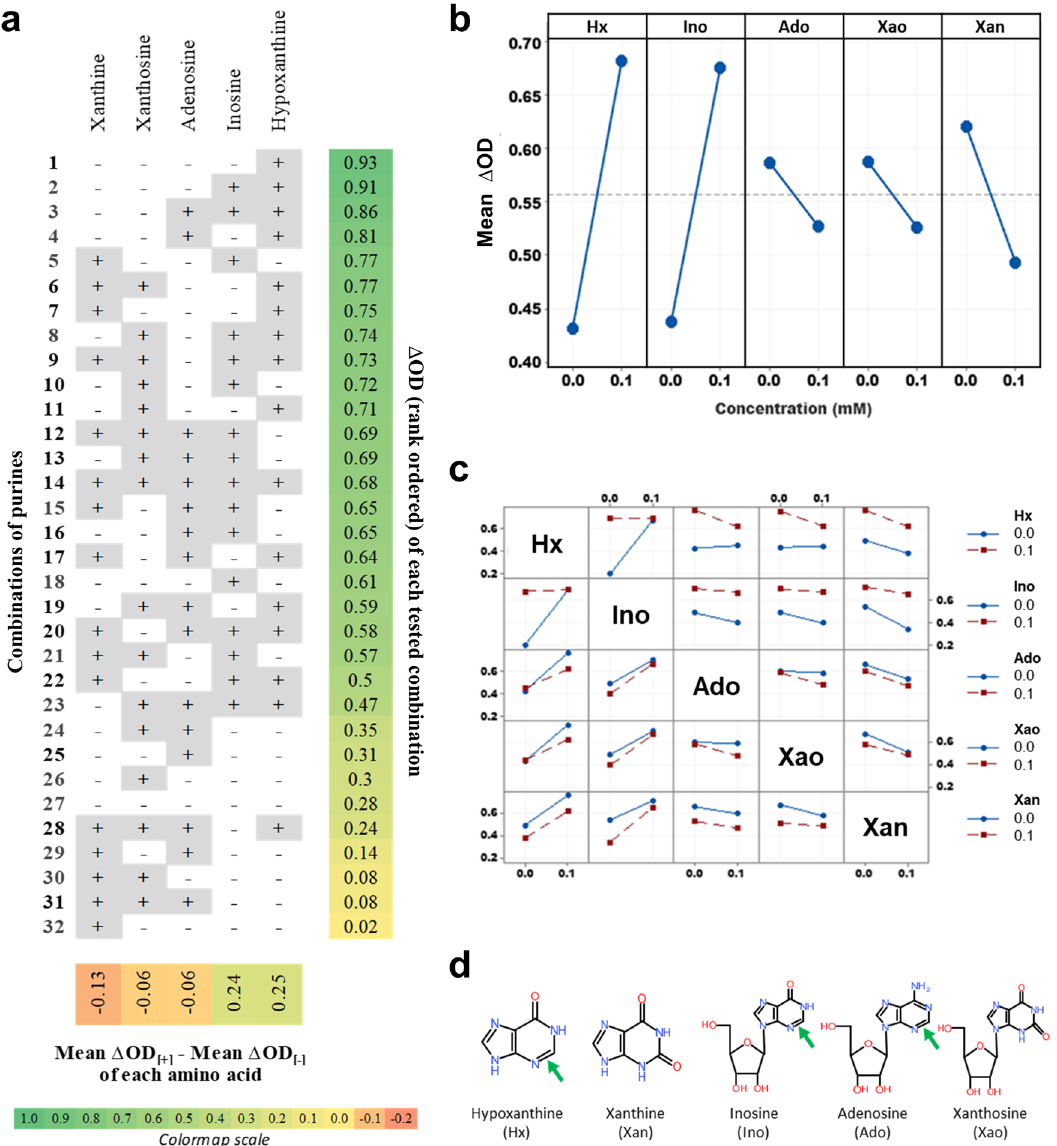
Fig. 3 Purine co-germinant full factorial screen with L-cysteine. Germination response was measured in the presence of L-cysteine (10 mM) for all combinations of purines (0.1 mM) according to the factorial design detailed in Supplementary Table 2 (panels a – c ). a Figure shows the different combinations of purines in the presence of main germinant L-cysteine, sorted in decreasing order (from top to bottom) of Δ OD (extreme right column) as de fi ned in Supplementary Table 4. Figure also shows the effect (bottom row) of each purine on Δ OD, arranged in increasing order from left to right. b Main interactions plot for the fi ve purine analogs (blue lines with circles, model ɑ = 0.0005). c Secondary interaction plot showing the interactions between all pairs of factors. Blue lines with circles represent absence and red lines with circles represent presence of indicated purines. d Structures of the fi ve purine analogs. A reduced purine ring featuring a C2-N3 double bond (green arrow) is associated with germination. All data were averaged from two independent experiments with two replicates each and represent mean response